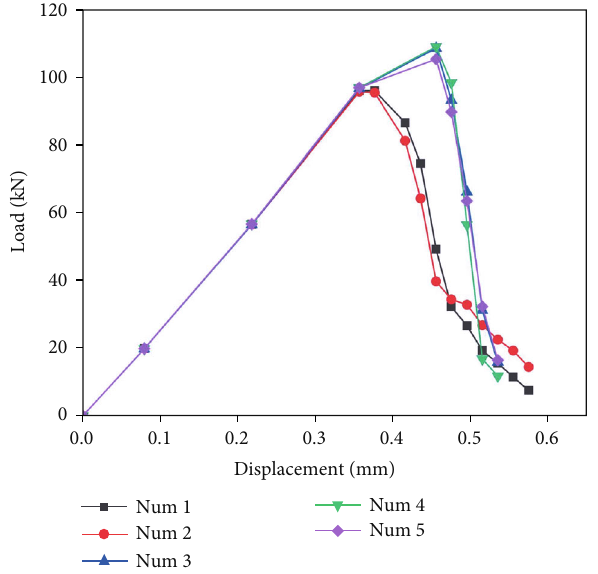
Figure 9: Load-displacement curves of di ff erent physical models under the same parameters and boundary